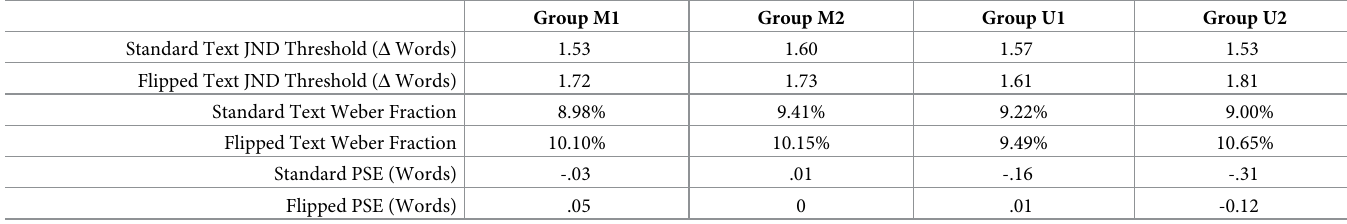
Table 1. Descriptive statistics from psychometric functions: Compared to standard text, flipped text generated similar, though marginally worse (higher), sen- tence-length JND thresholds and Weber fractions. This pattern held for mirror-reversed text (Groups M1 and M2) and upside-down text (Groups U1 and U2) alike. Across conditions, the point of subjective equality (PSE) consistently fell within 0.4 words of non-biased responding (PSE = 0).